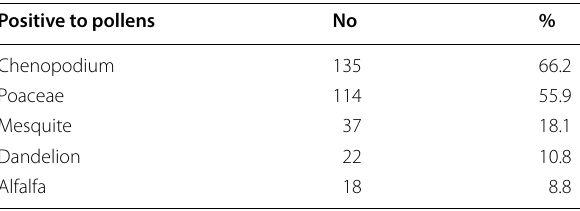
Table 3 Results of the frequency of sensitizing to pollen